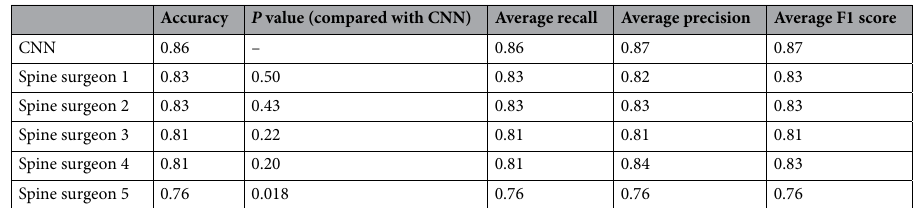
Table 3. Performance metrics of the CNN and spine surgeons of diagnoses made using lateral cervical spine radiographs. CNN convolutional neural network.